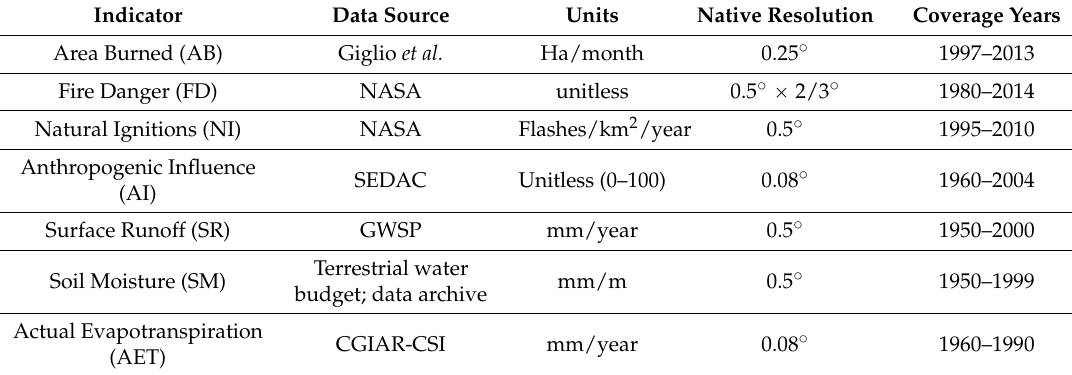
Table 1. Summary of datasets used to develop the GWWEI indicators. NASA: National Aeronautic and Space Administration, SEDAC: Socioeconomic Data and Applications Center, GWSP: Global